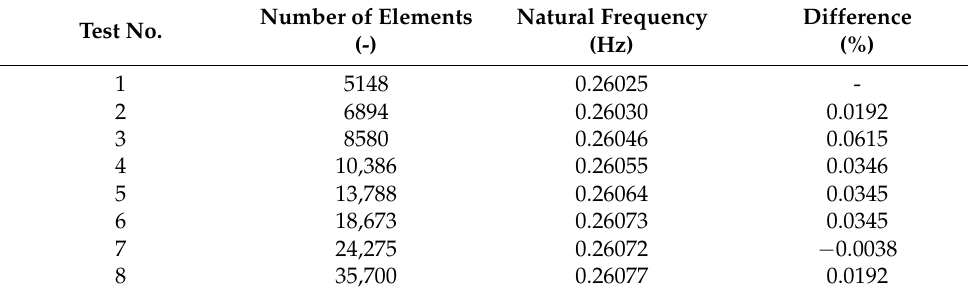
Table 4. Results of mesh convergence